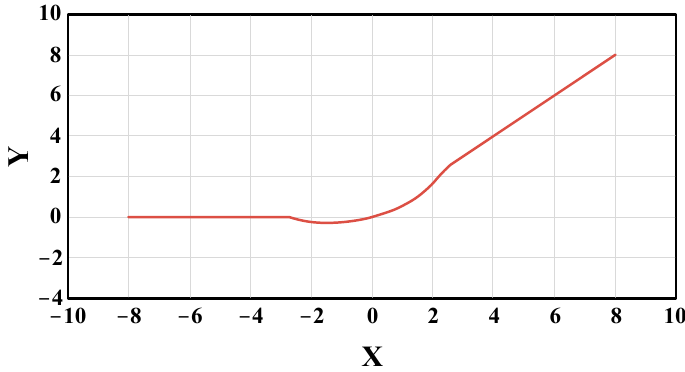
Figure 13. Graph of hard-swish activation function.